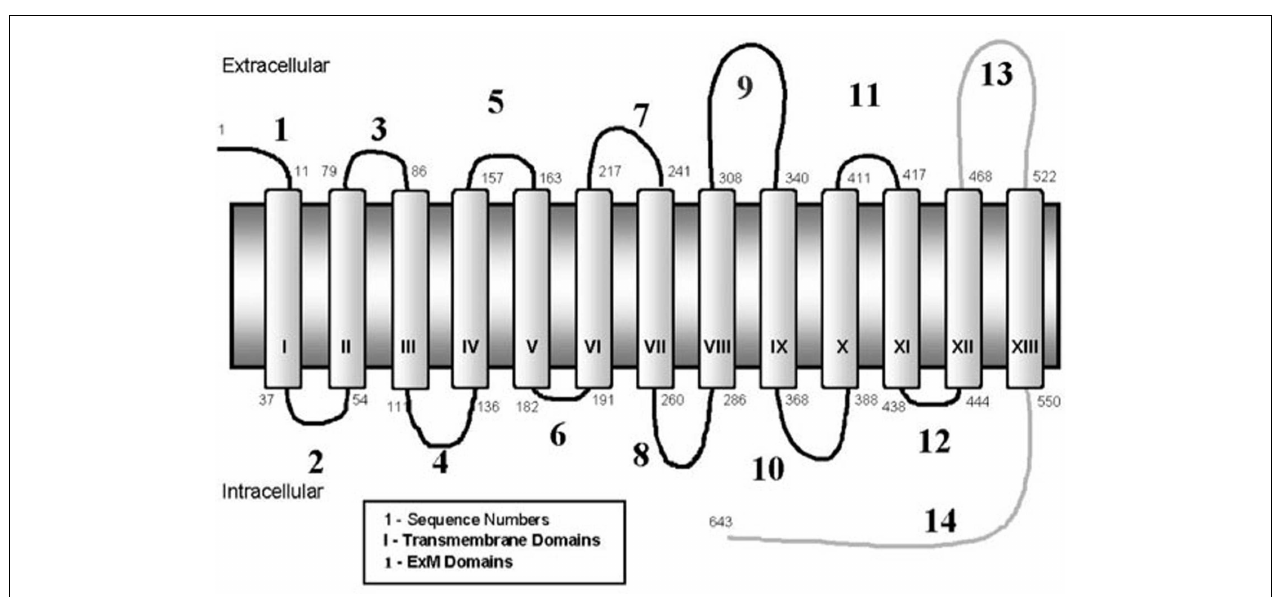
FIGURE 1 | Structure of the human sodium-iodide symporter (hNIS).